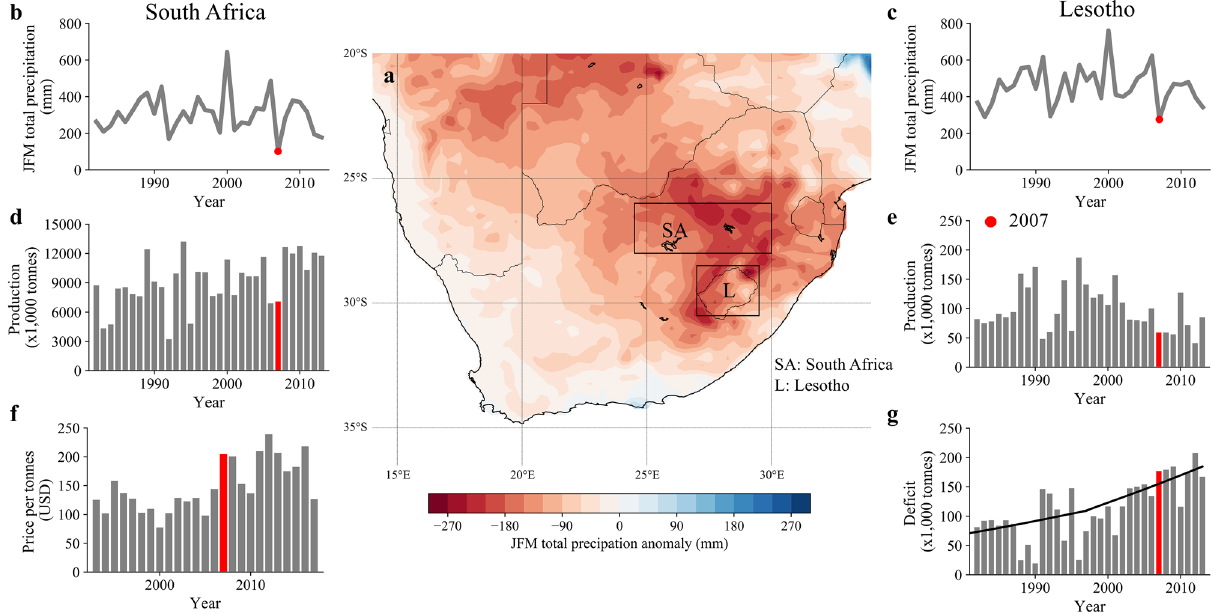
Figure 1. Overview of 2007 drought and impacts. ( a ) Spatial distribution of the JFM precipitation anomaly over South Africa (relative to 1979–2018 average) derived from reanalysis data 17 , with the boxes indicating the areas that the climate data is averaged over. ( b ) JFM precipitation time series for South Africa with the 2007 event highlighted in red. ( c ) Same as ( b ) but for Lesotho. ( d ) Maize production data from the FAOSTAT database 18 with the 2007 event in red. ( e ) Same as ( d ) but for Lesotho. ( f ) Price per tonnes for maize in South Africa from FAOSTAT. Note only data from 1991 onwards is available. ( g ) Maize deficit (minimum maize demand for sufficient calorie intake minus domestic production) over time in Lesotho, with the black line showing the non-linear trend line over the years, derived using a lowess function. Figure ( a ) was generated using the ‘Basemap’ package (https ://matpl otlib .org/basem ap/index .html) and Python Programming Language (version